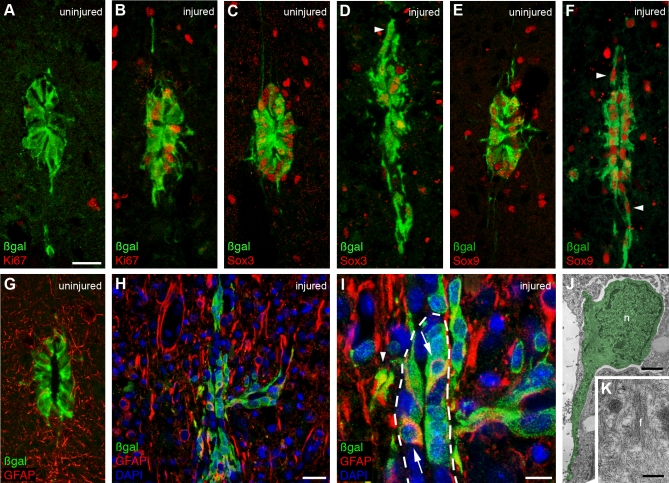
Ependymal Cells Are Activated by InjuryUninjured and adjacent injured segments from mice 4 d after a dorsal funiculus incision. Recombined cells leave the ependymal layer in the injured segments (arrowheads). (A and B) Ki67 immunoreactivity indicates ependymal proliferation in the injured, but not in the uninjured segment. Migrating recombined cells lose Sox3 expression (D), but most are Sox9 immunoreactive, and a smaller population is GFAP immunoreactive (F–I). Some ependymal cells within the ependymal layer (outlined by hatched line in [I]) become GFAP immunoreactive (arrows). (J and K) Electron micrographs of an extended ependymal cell with a dense filamentous matrix (f) in the cytoplasm 4 wk after injury in a FoxJ1-CreER mouse. n, nucleus.Scale bars indicate 25 μm in (A–H), 10 μm in (I), 1.5 μm in (J), and 0.2 μm in (K).